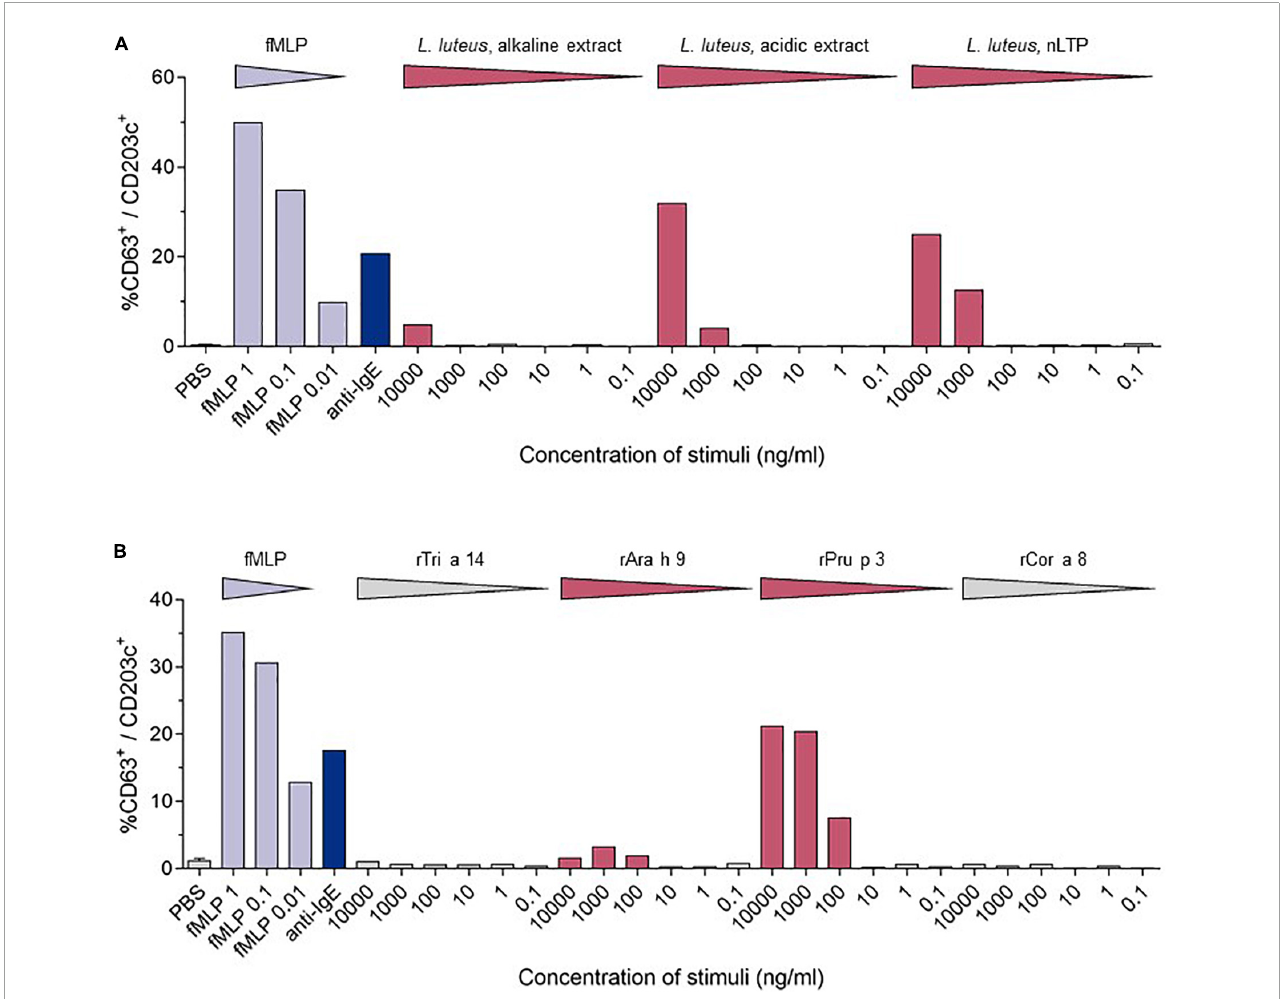
FIGURE2 Comparison of the stimulation-induced basophil activation levels. Basophil activation was measured by the percentages of CD63 positive basophils (CD203c + /Fc (cid:101) RI α + ). PBS—phosphate-buffered saline, fmIP- formyl-, methionyl-leucyl phenylalanine. (A) Results of the BAT for LTPs from Lupinus luteus [acidic extract; alkaline extract; nLup l 3 (LTP)] (10). (B) BAT results from wheat (rTri a 14), peanut (rAra h 9), peach (rPru p3), and hazelnut (rCor a